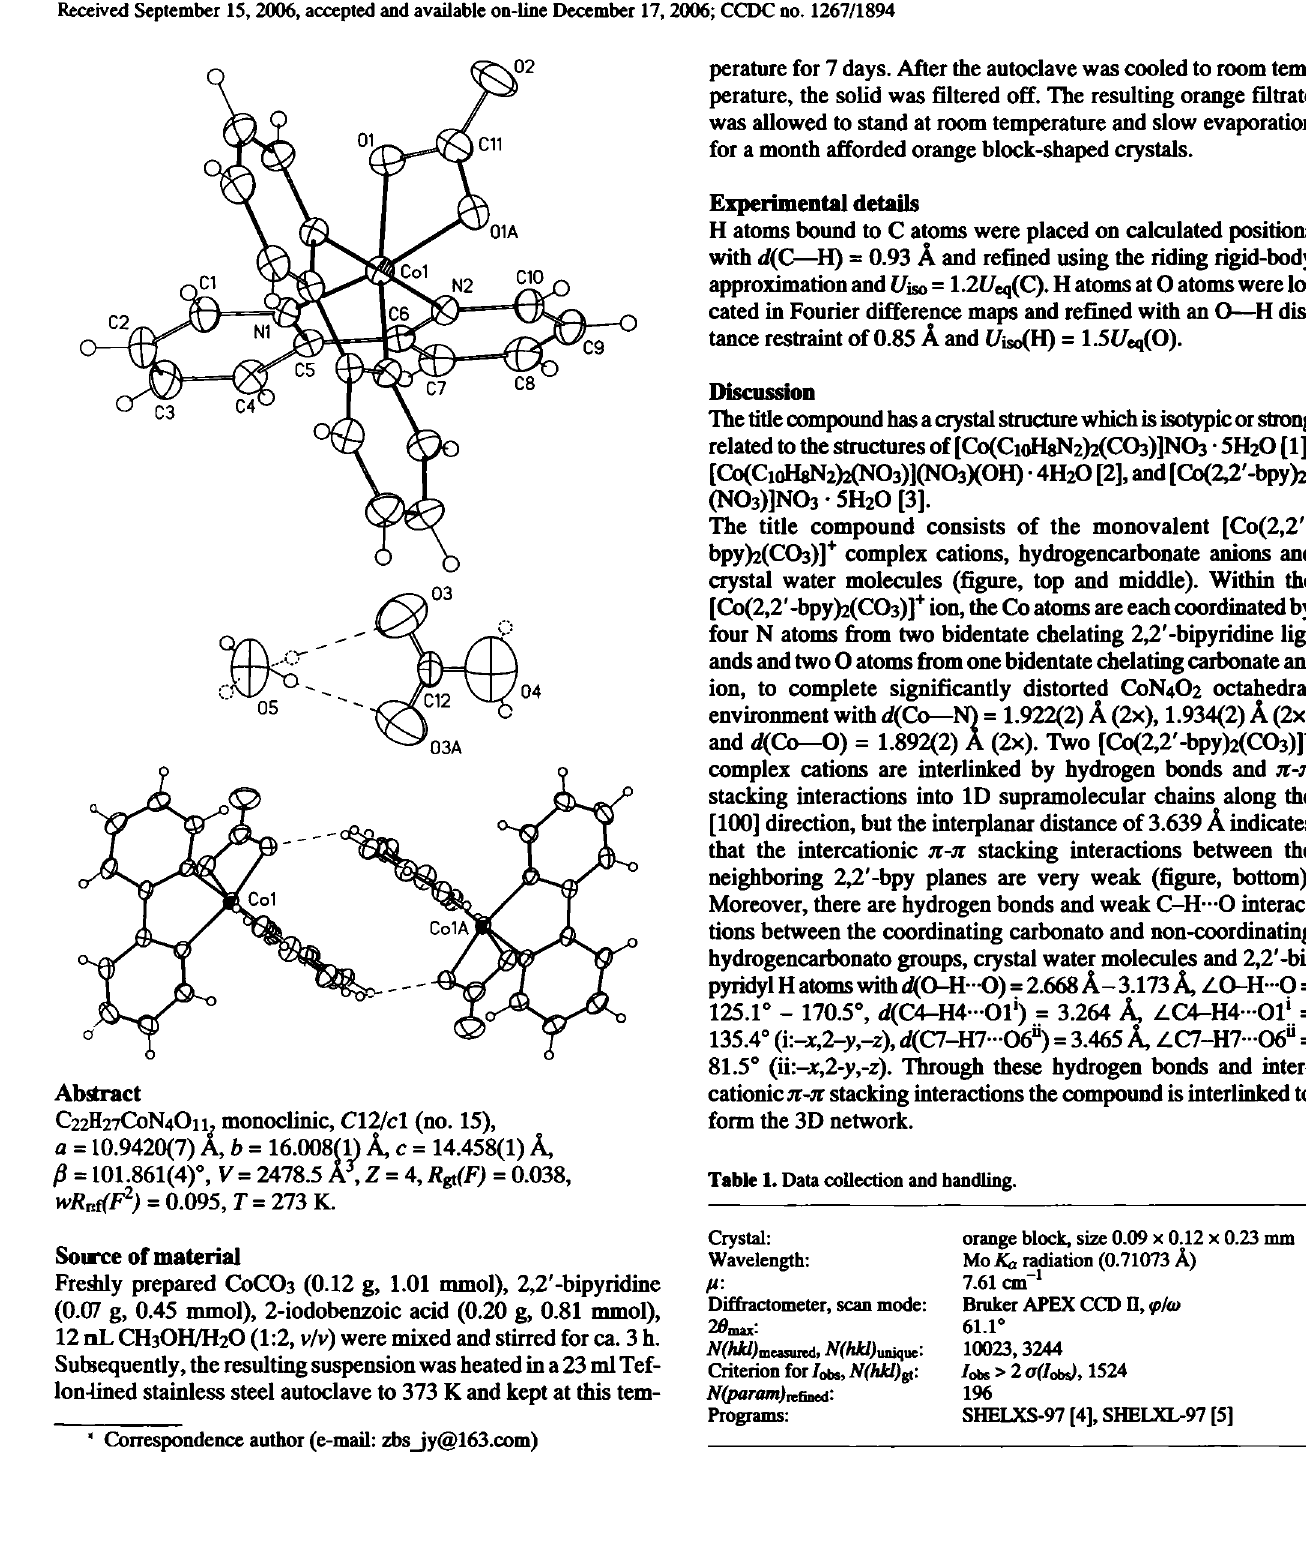
Table 1. Data collection and